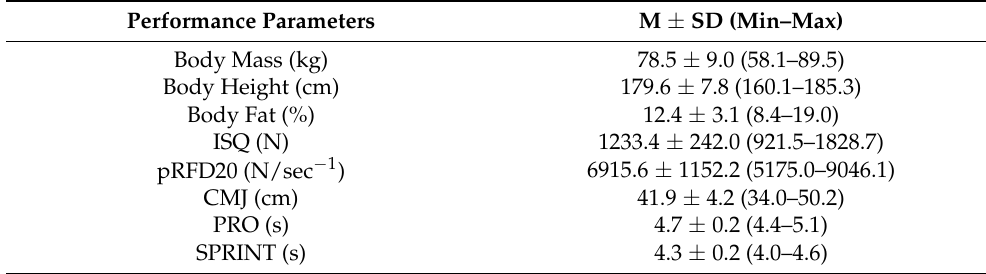
Table 1. Anthropometric and performance parameters. ISQ = isometric squat; pRFD20 = peak rate of force development; PRO = pro-agility test.